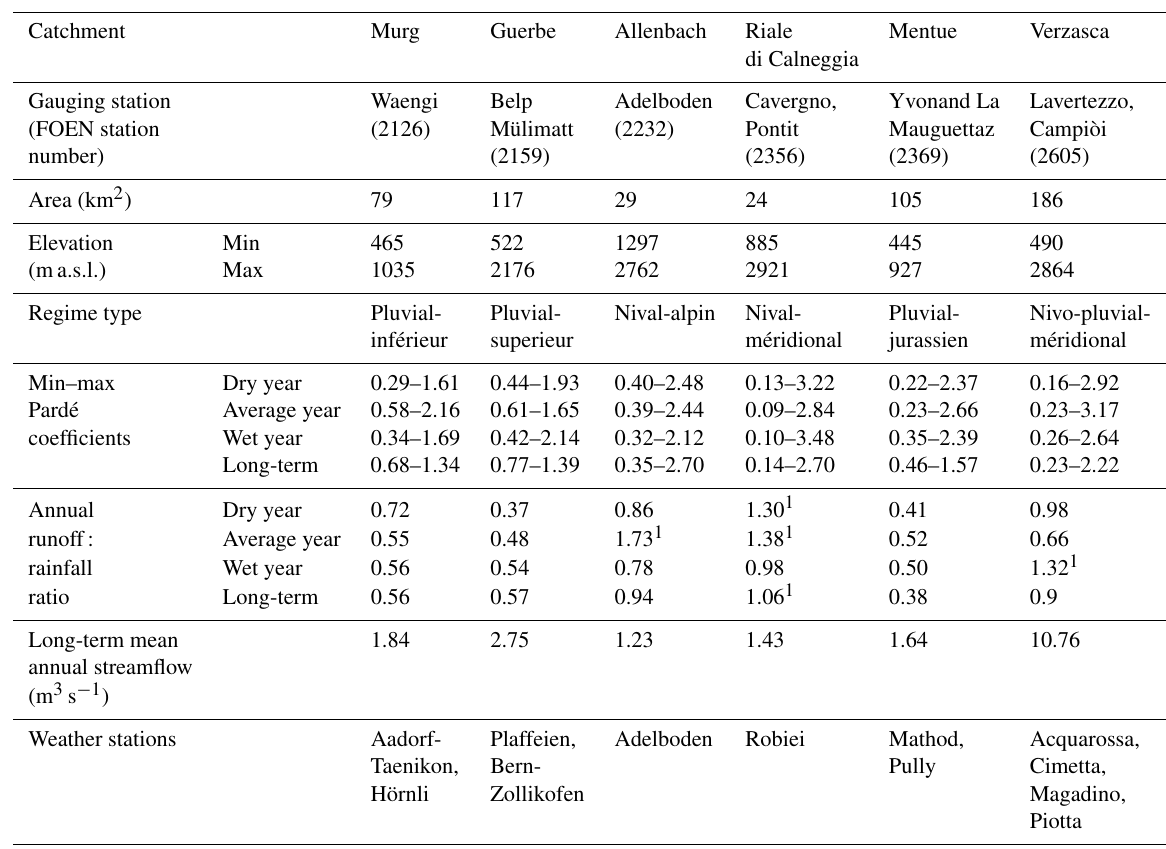
Table 1. Characteristics of the six Swiss catchments used in this study. For the location of the study catchments, see Fig. 1. Long-term averages are for the period 1974–2014, except for Verzasca for which the long-term average is for the 1990–2014 period. Regime types are classified according to Aschwanden and Weingartner